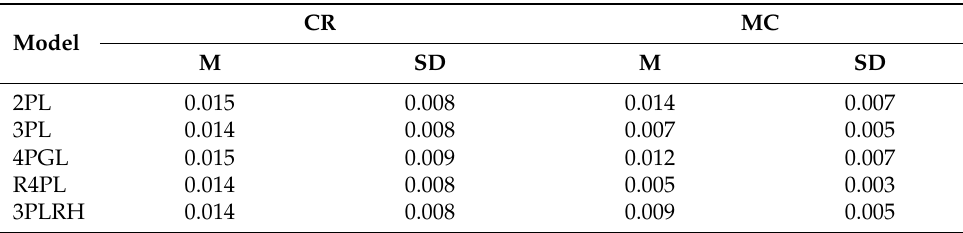
Table 5. PIRLS 2016 reading: mean (M) and standard deviation (SD) of RMSD item fit statistics in different scaling